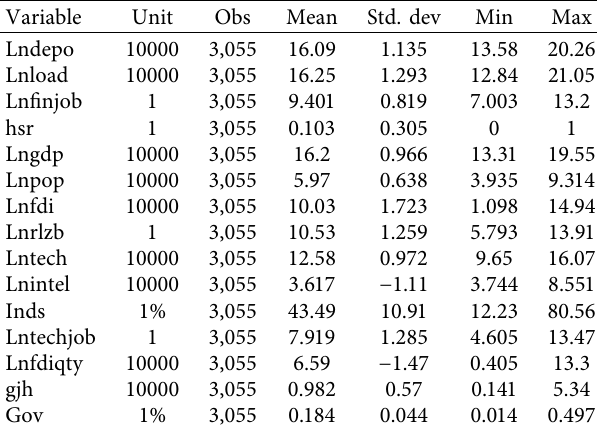
Table 1: Descriptive statistics of the